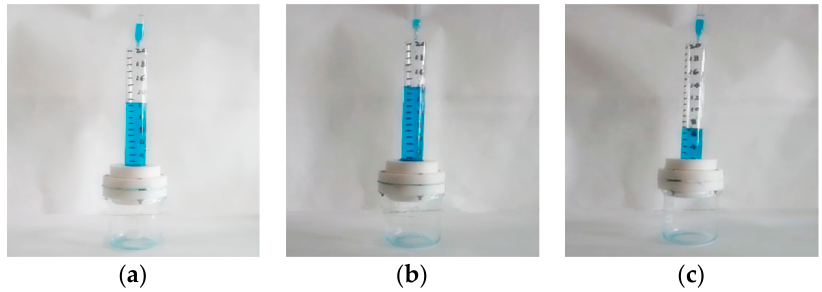
Figure 11. ( a ) The device used for highest pressure resistance; ( b ) apparatus of pressure resistance performance test for the parabolic morphology; ( c ) apparatus of pressure resistance performance test for the truncated cone morphology.